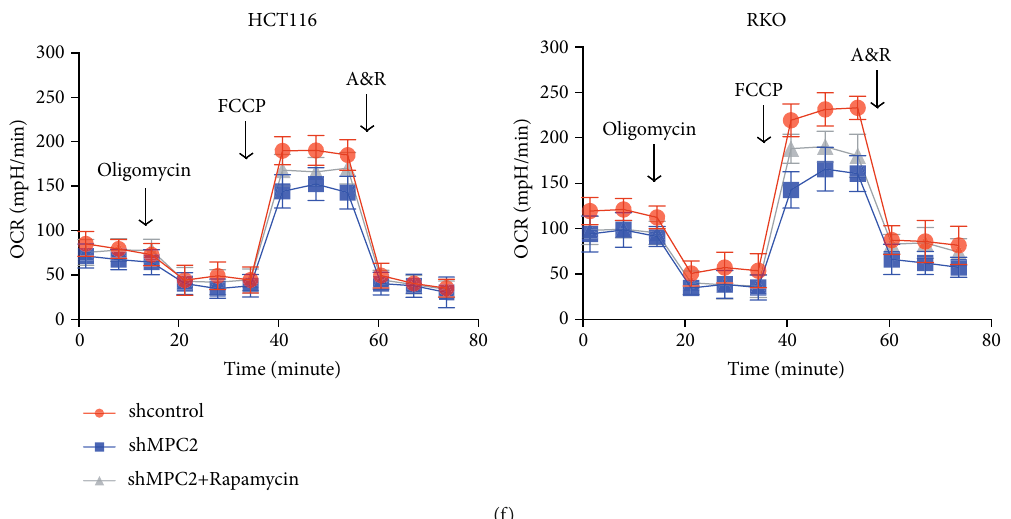
Figure 4: MPC2 reduced glycolysis level via mTOR pathway in CRC cells. (a) GSEA from CRC tissues from the TCGA database. (b) Western blotting images of phospho-mTOR (p-mTOR) and mTOR in HCT116 and RKO cells with shNC or shMPC2 transfection and/or rapamycin treatment (50 nmol/L). (c) Lactate production and glucose consumption of CRC cells with shNC or shMPC2 transfection and/or rapamycin. (d) Relative mRNA expression of glycolysis-related genes of HCT116 and RKO cells with shNC or shMPC2 transfection and/or rapamycin treatment. (e) Glycolytic function of RKO and HCT116 cells under the indicated treatments as measured by ECAR. (f) Mitochondrial stress test RKO cells (right) and HCT116 cells (left) under the indicated treatments as measured by oxygen consumption rate (OCR). ∗ p < 0 : 05 , ∗∗ p < 0 : 01